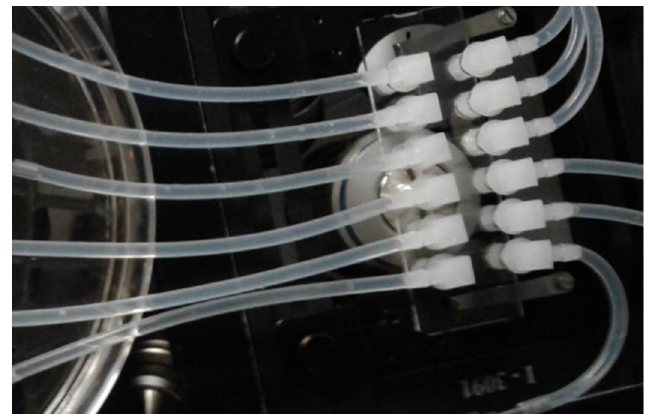
Figure 7. The Ibidi flow cell (Slide VI 0.4 Ibi Treat; Ibidi, Fitchburg, WI, USA) assembly on the stage of inverted Zeiss AxioObserver microscope. Row of six elbow plug connectors attached to silicone tubing (inflow; on the right) bring fluids to 6 flow cell’s channels (not visible; 0.4 mm high, 3.8 mm wide) leading to six elbow connectors of the outflow (silicone tubing on the left). Inverted objective lens is visible under the flow cell.